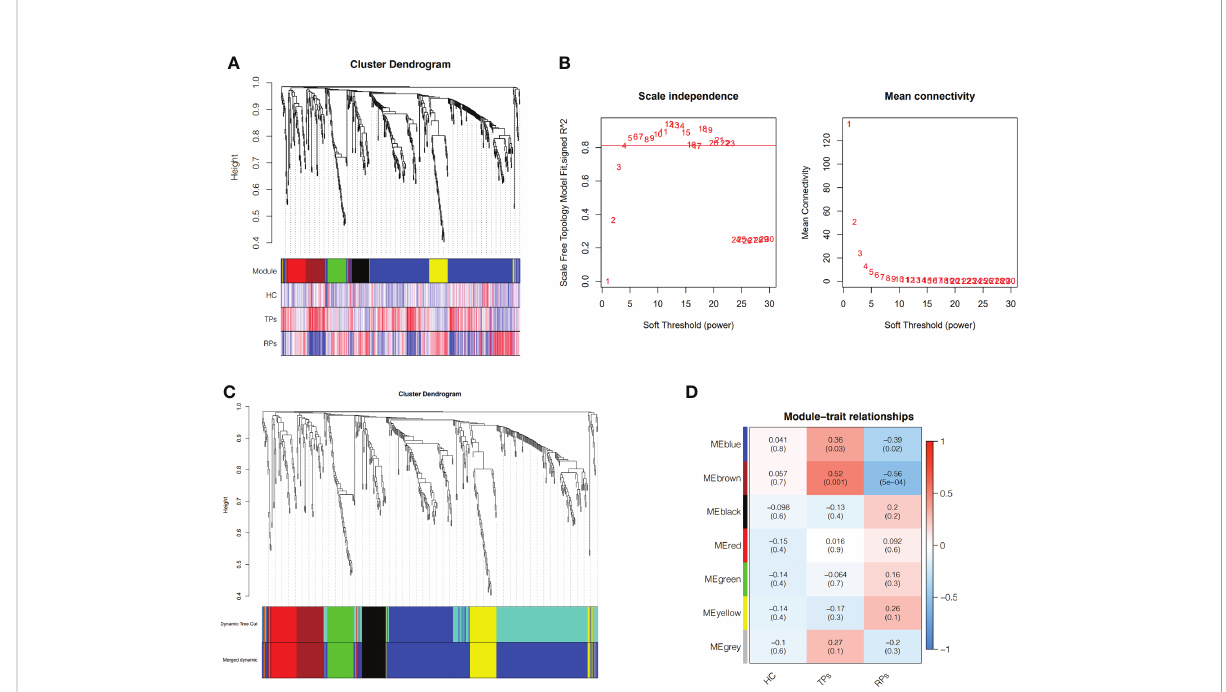
FIGURE 5 Weighted Co-Expression Network Construction and identi fi cation of key modules. (A) Clustering dendrogram of 35 samples with trait heatmap. (B) Determination of soft-threshold power in the WGCNA. (C) Merged module tree of miRNAs, with dissimilarity based on the topological overlap, together with assigned module colors. (D) Heatmap of the correlation between the module eigengenes and clinical traits of HIV. Brown and blue modules were selected for further analysis.